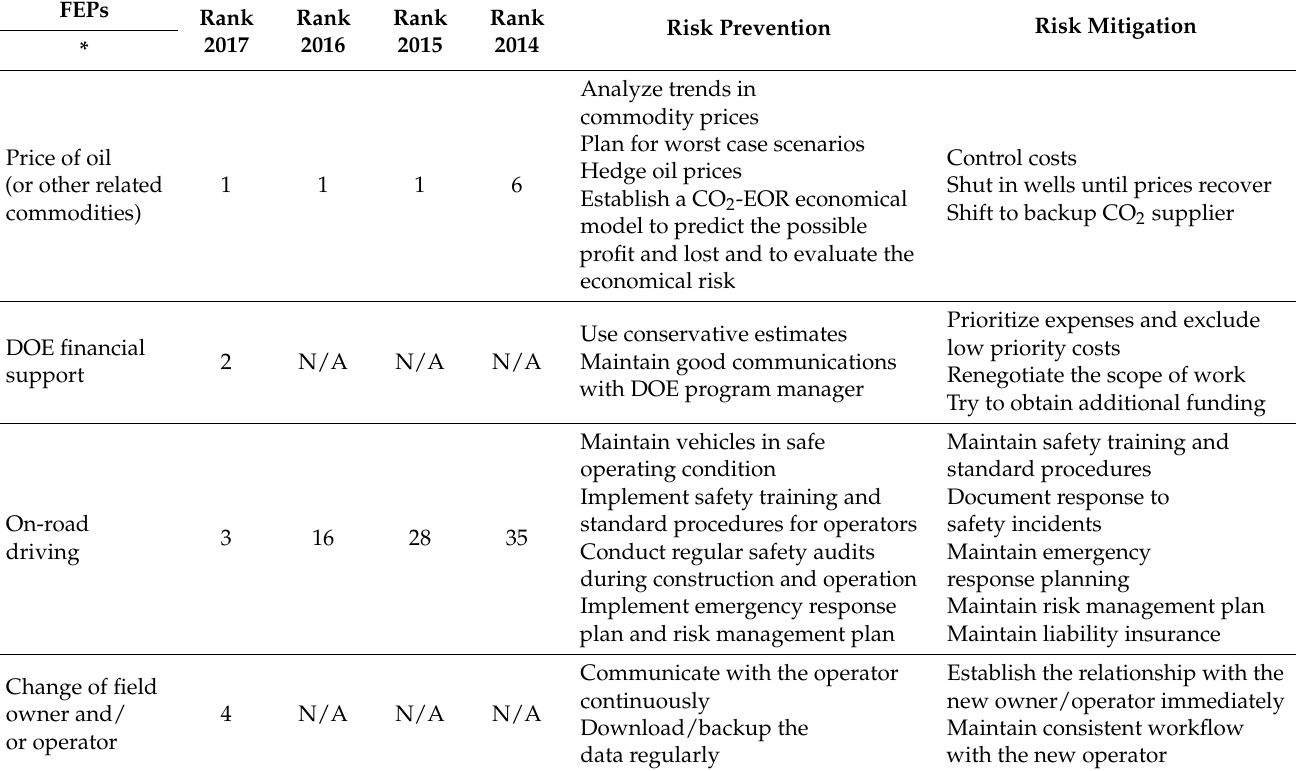
Table 4. Prevention and mitigation treatments for the top 10 FEPs of 2017 risk